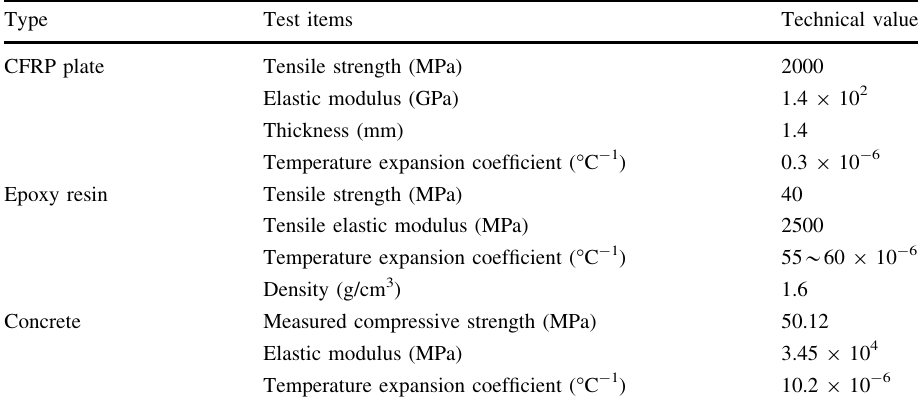
Table 2 Properties of test